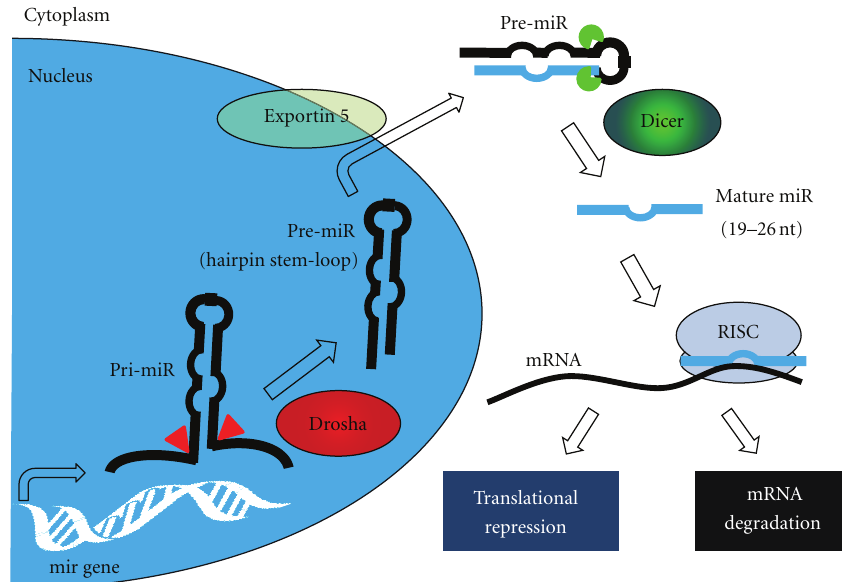
Figure 1: Schematic summary of miRNA biogenesis and mechanism of action to inhibit protein